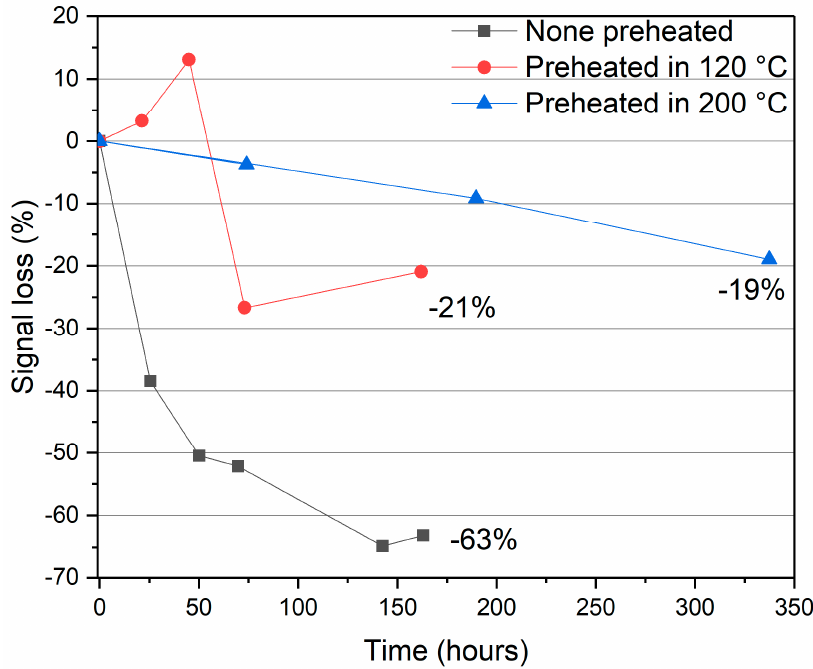
Figure 14. Dependencies of TL signal integral time after irradiation for preheated PPG_Tb30 glass dosimeter irradiated with beta radiation (4 μ s pulse duration).